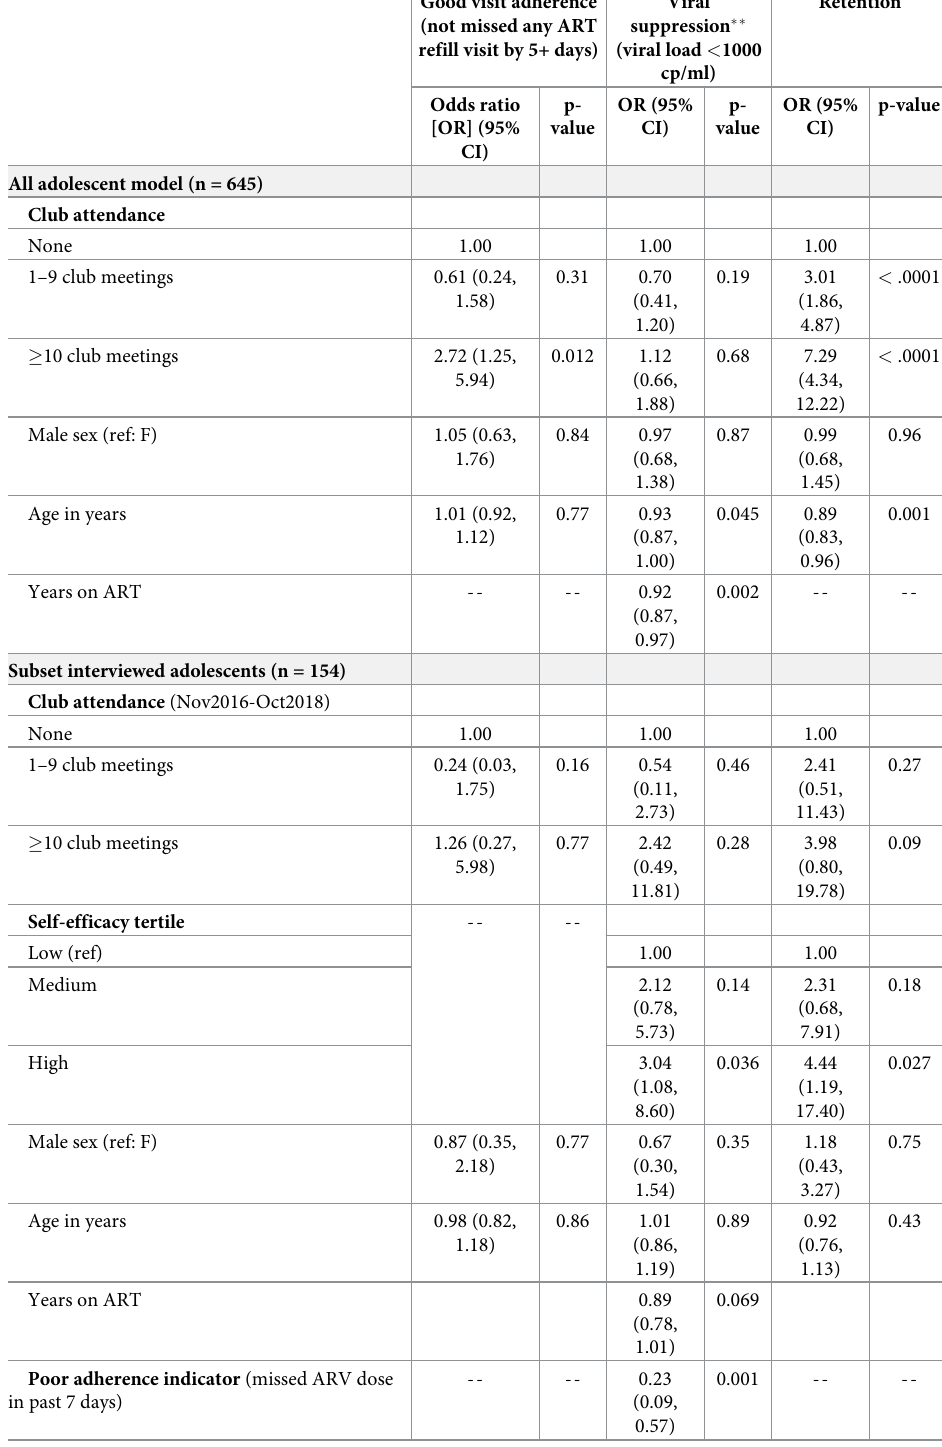
Table 3. Facility-adjusted � logistic regression modelling of associations between adolescent club attendance and study outcomes among all adolescents attending study sites and the subset of adolescents enrolled and